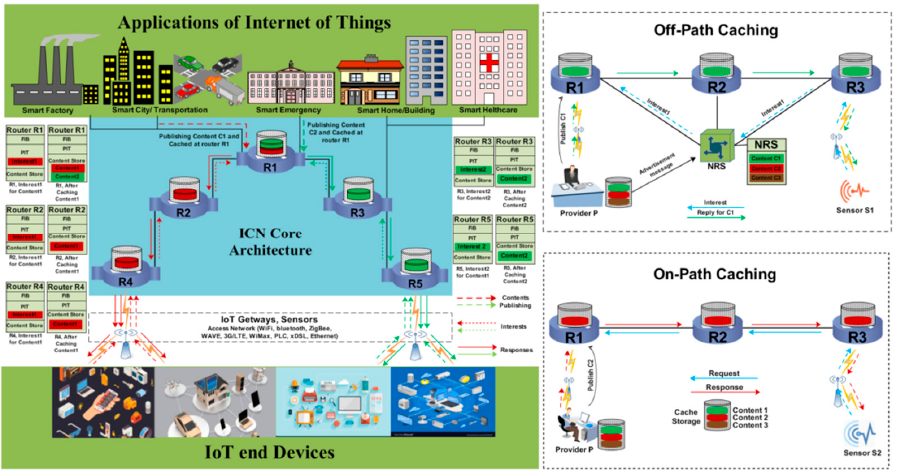
Figure 1. Caching architecture, On-path and Off-path caching.